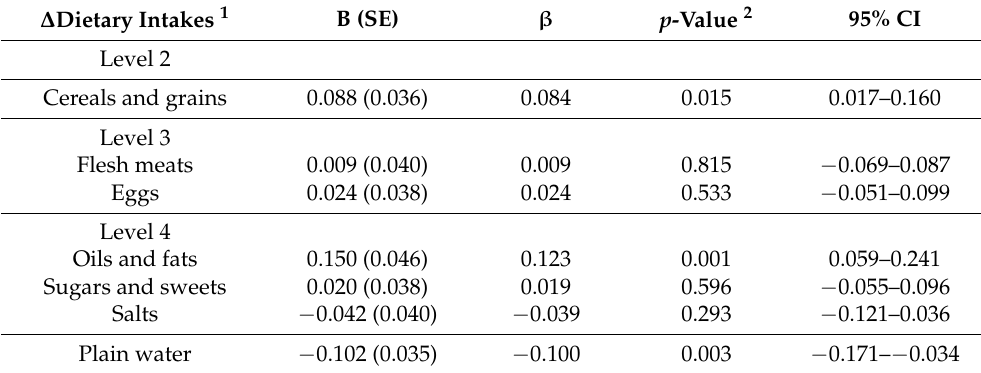
Table 4. Predictors of weight gain during the COVID-19 lockdown.